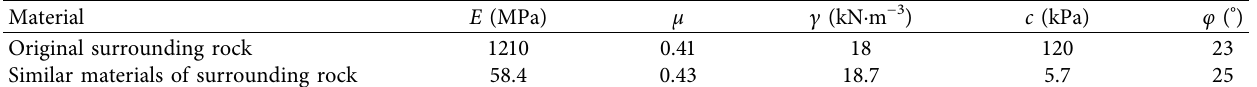
Table 2: Physical and mechanical parameters of surrounding rock.